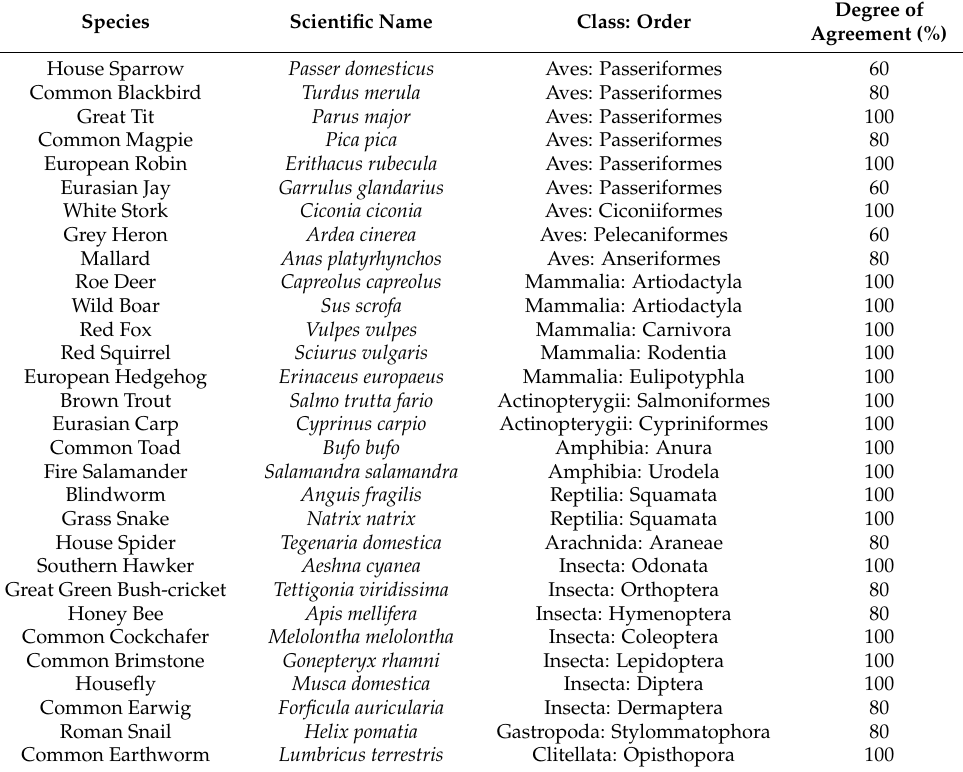
Table 1. Degree of agreement of the expert opinion on which species should be included in the questionnaire. The common English name, the scientific name as well as the class and order of the respective species are